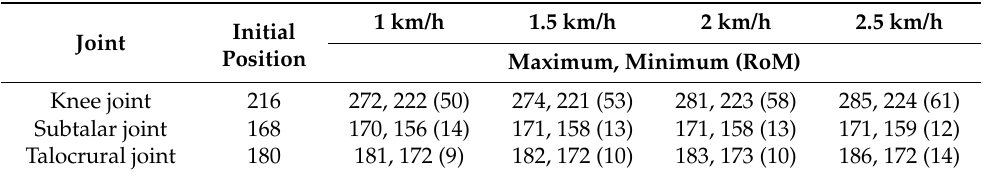
Table 8. Initial position and range of motion (RoM) of each joint.